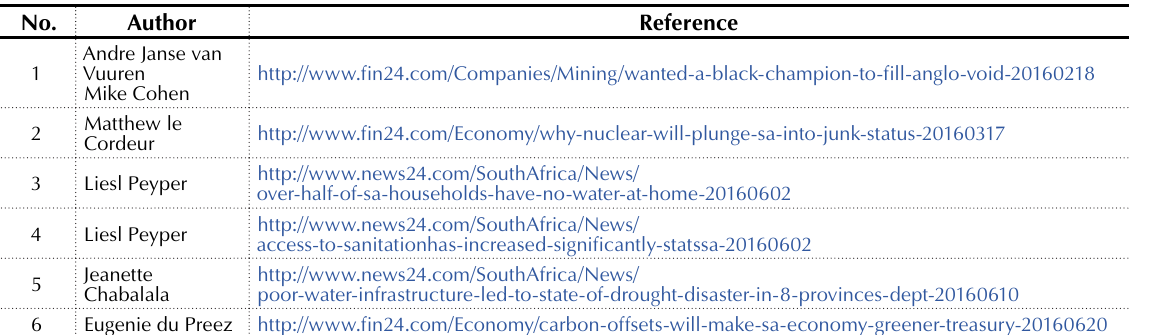
Table 6B. Structural-physical macro-environment